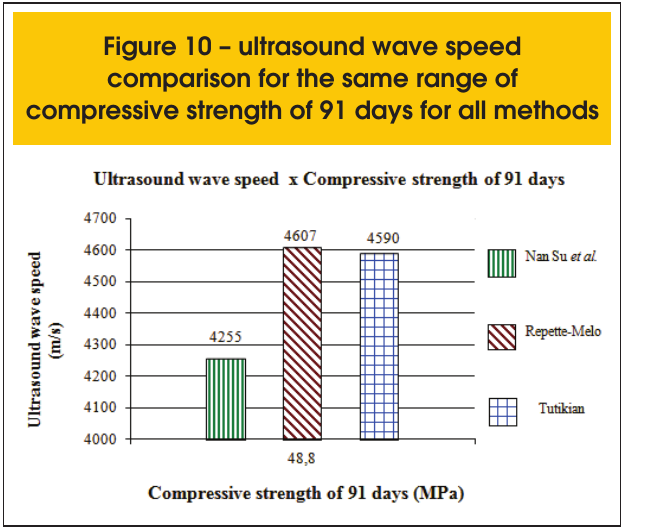
Figure 11 – chloride ions penetration comparison for the same range of compressive strength of 91 days for all